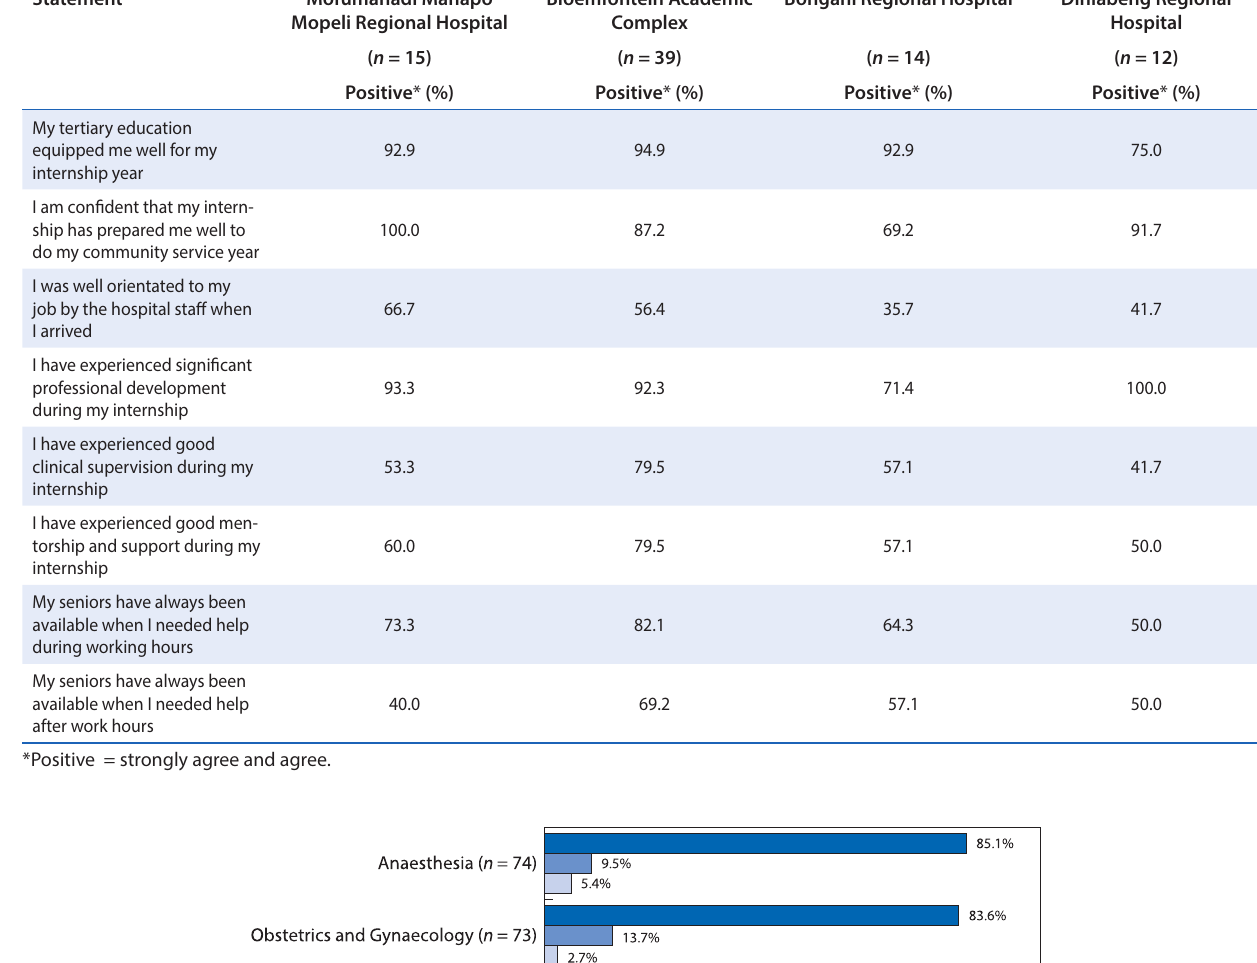
Table 1: Experiences of medical interns in the Free State per healthcare facility ( n = 80)